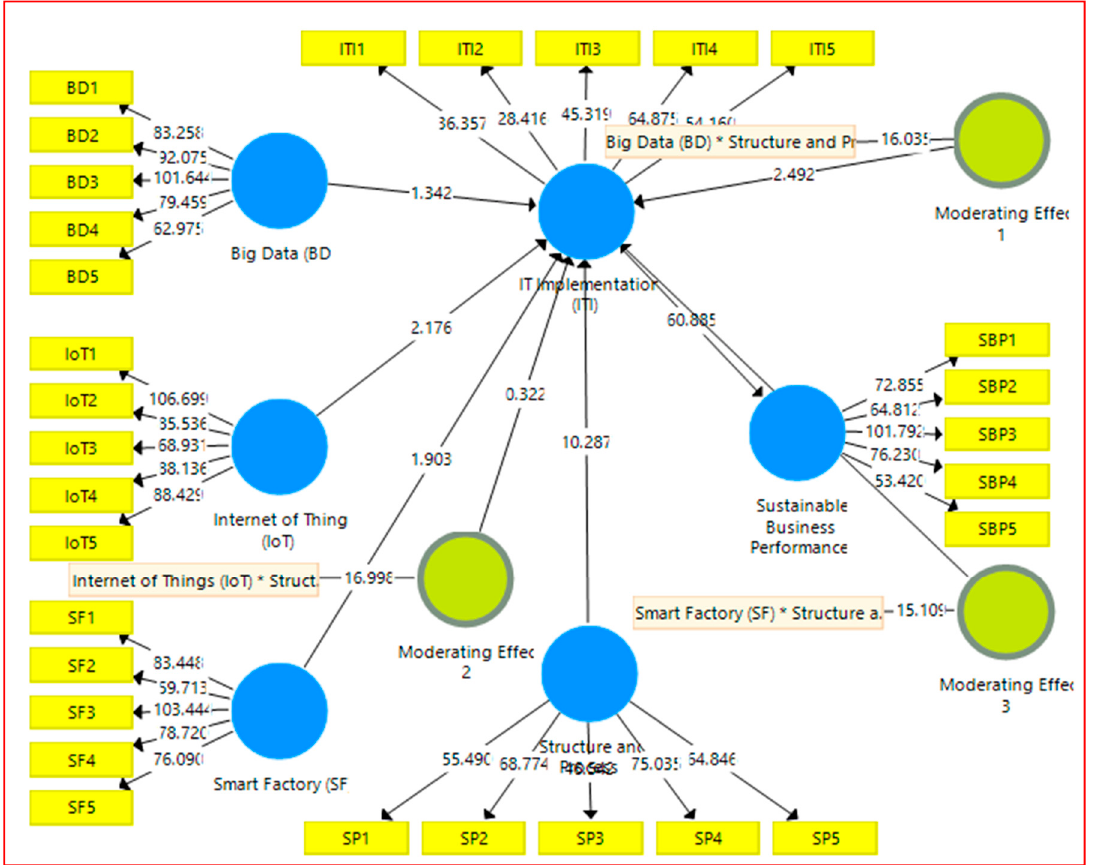
Figure 9. Structural Model Assessment (Moderation E ff